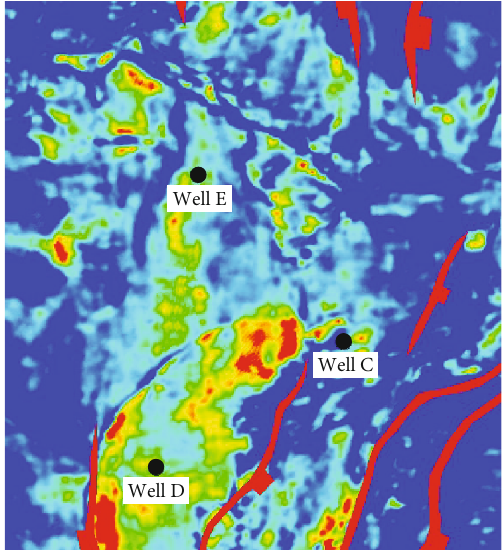
Figure 7: RMS attribution of the P-wave of RMS prediction map of igneous distribution.